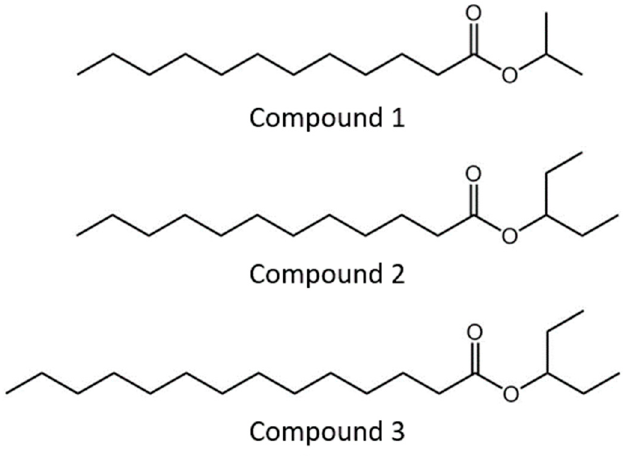
Figure 1. Chemical structure of ester in aggregation pheromone of Lyctus africanus.